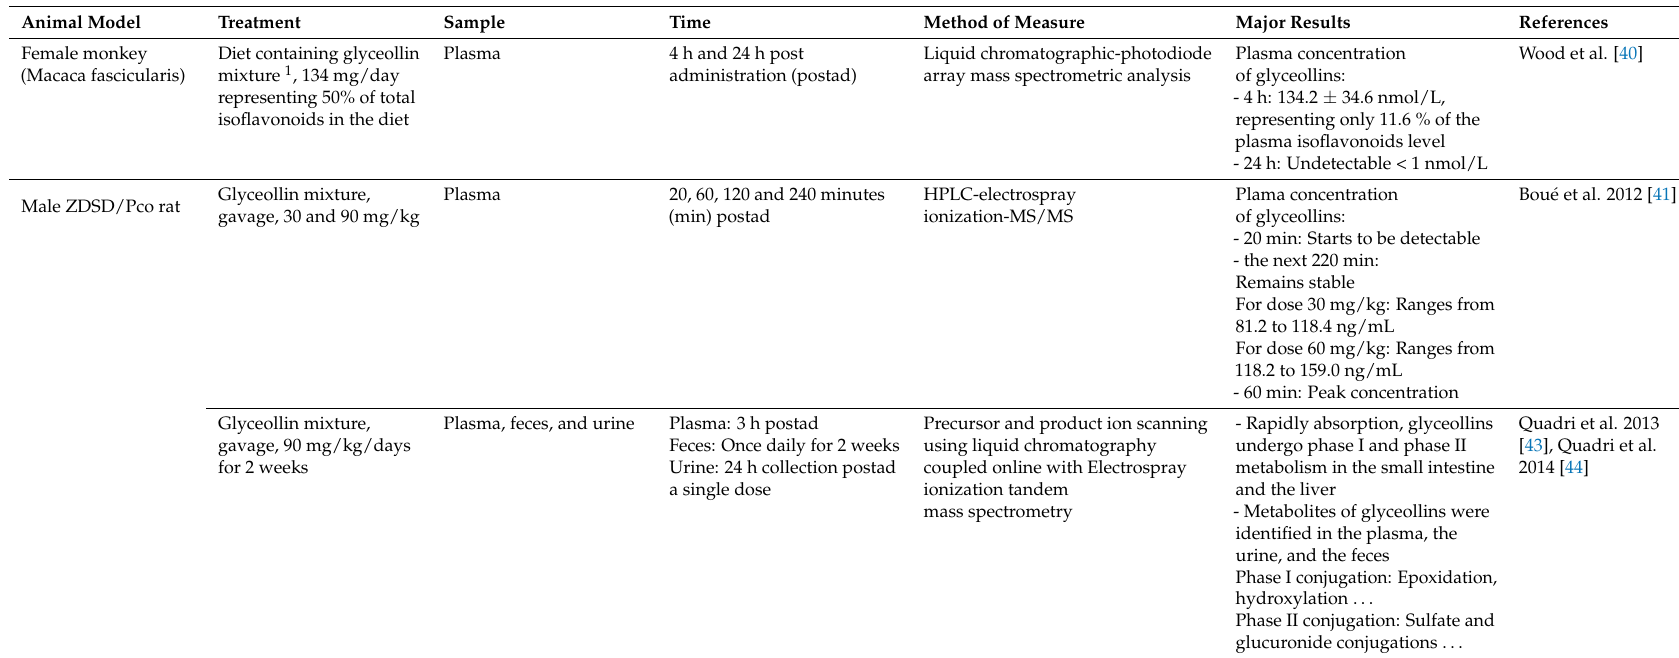
Table 1. Bioavailability of